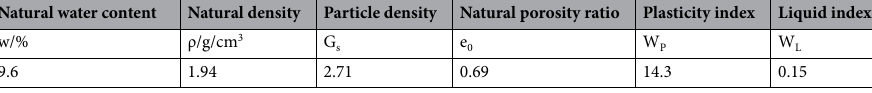
Table 1. Basic physical parameters of tailings